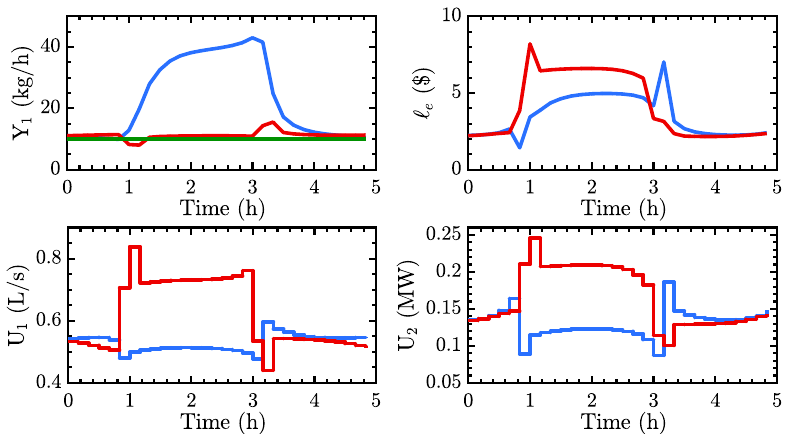
Figure 6. CO 2 emission, input and economic cost trajectories of the PCC plant with carbon tax set at $50.00 per tonne CO 2 . The set-point of MPC is not updated. EMPC (blue), MPC (red), Emission limit (green); ( top-left ) mass flow rate of CO 2 in the treated flue gas; ( top-right ) economic performance of controller; ( bottom-left ) volumetric flow rate of solvent; ( bottom-right ) heat input to reboiler. PCC: Post-combustion CO 2